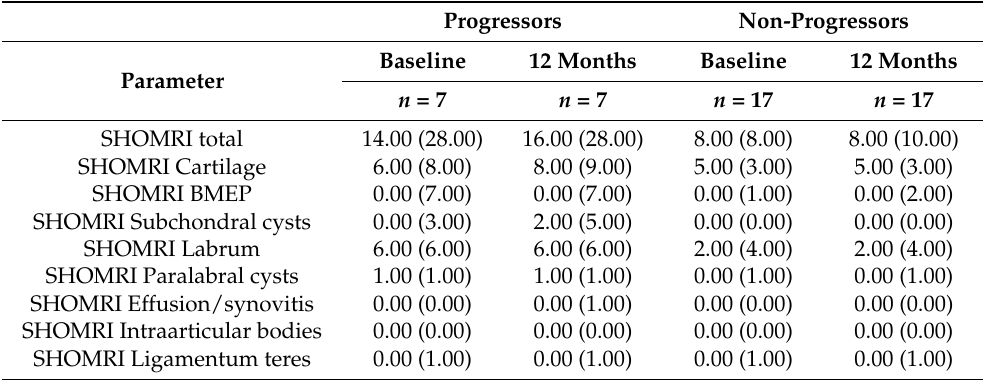
Figure 1. Progression of chondral defects missed by SHOMRI. Baseline MRI ( A ) showing a full thickness cartilage defect (arrow) corresponding to SHOMRI grade 2 in a superolateral acetabular region in a 60-year-old patient. In a follow-up study ( B ), the defect covers a larger area (arrowheads show the margins of the defect), which still corresponds to SHOMRI grade 2. Table 5. MRI outcomes of symptomatic hip at baseline and 12-month follow-up in a group of SHOMRI progressors and non-progressors.